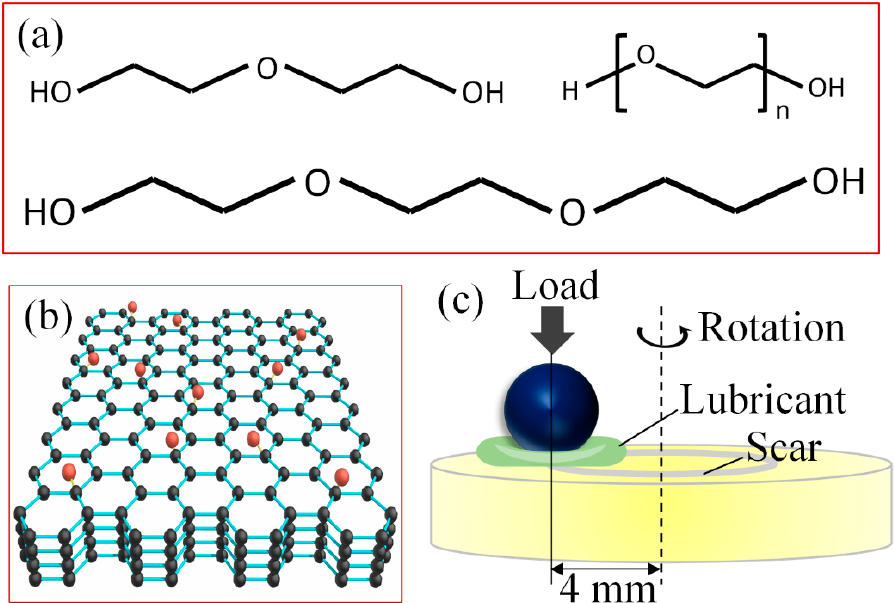
Figure 1. ( a ) The structure of DAs, ( b ) layered structure of graphene oxide, and ( c ) diagram of testing model.